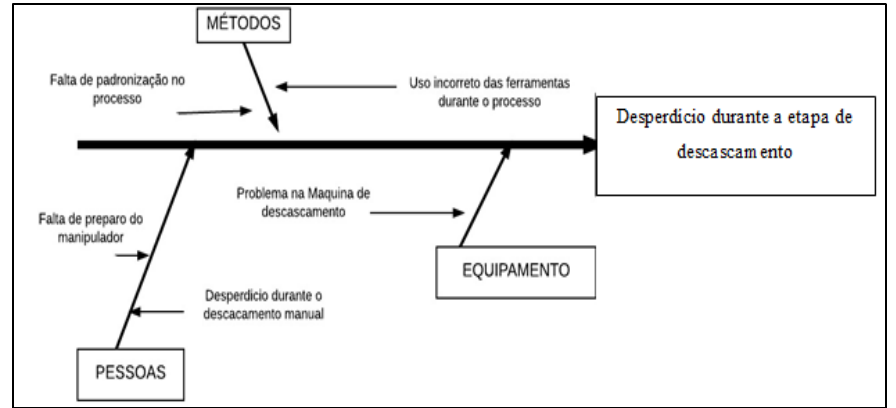
Figura 8: Diagrama de Ishikawa . Fonte: Autores, (2017).